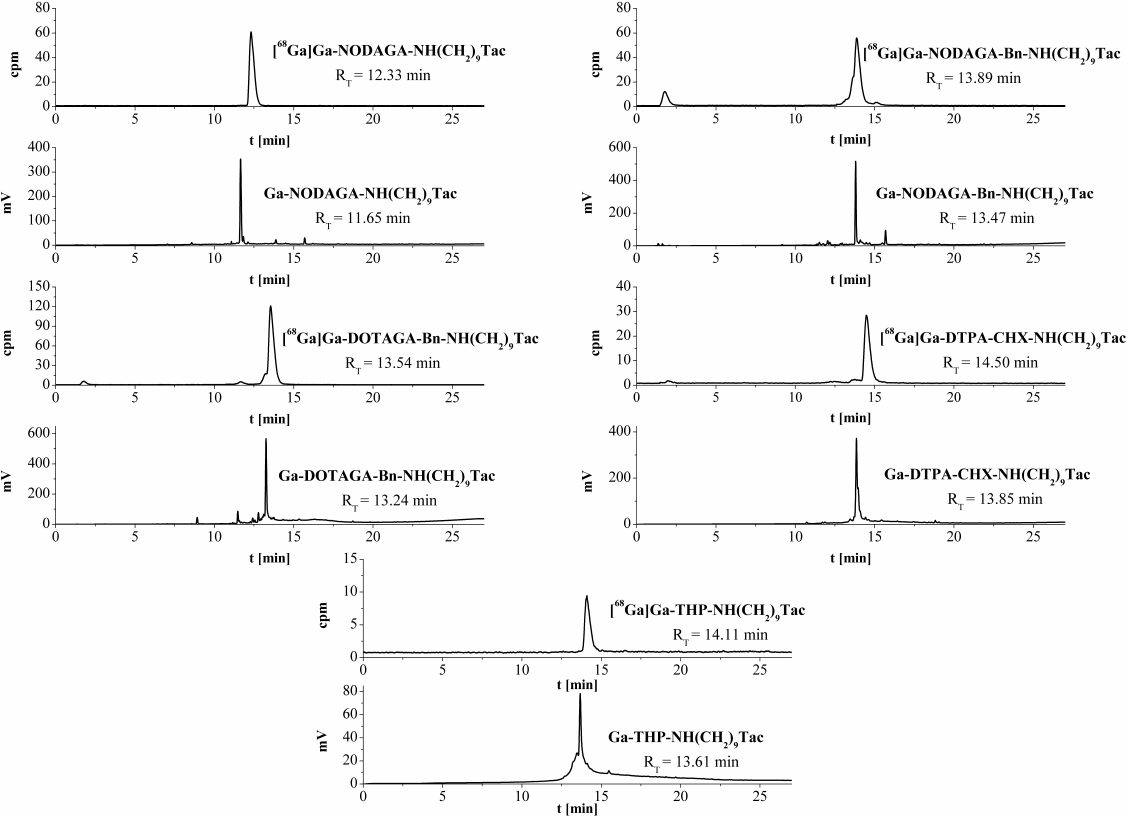
Figure 2. HPLC chromatograms of reaction mixture of the obtained radioconjugates and their reference